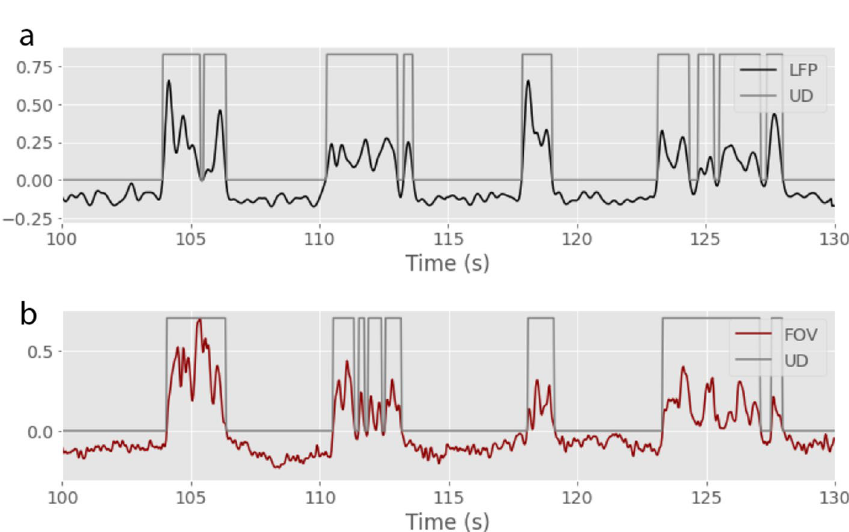
Figure 10. Up and Down state detection in LFP and calcium signals. Example of Up and Down state detection in a 30 seconds recording using the LFP ( a ) or the FOV ( b ) signals.